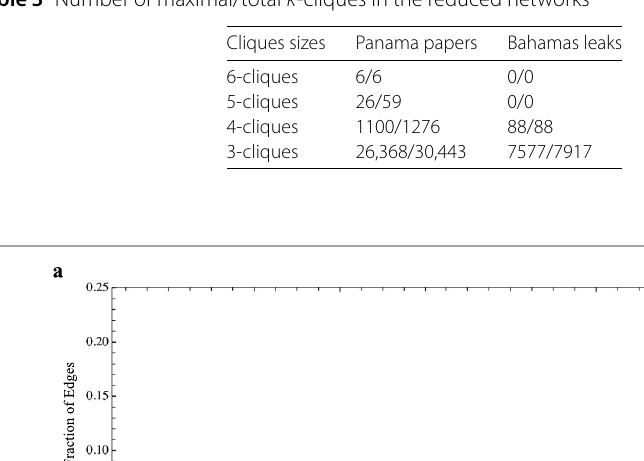
requirements established in the previously presented rules and particular Rule 1 of the Sect. 4.2 for lower-curvature nodes and Rule 4 for higher-curvature ones. The